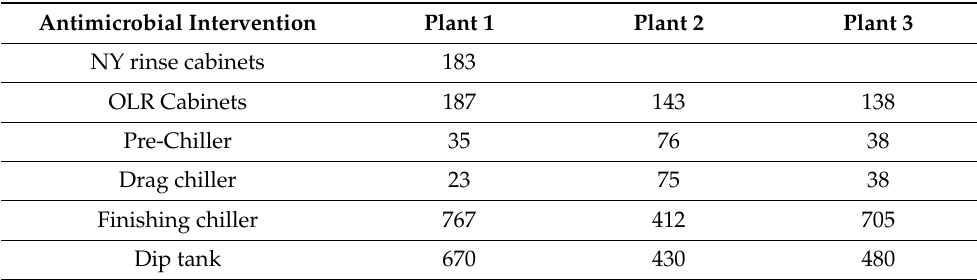
Table 1. Description of PAA concentrations (ppm) used at each step. Concentrations with the greatest impact on microbial levels are in